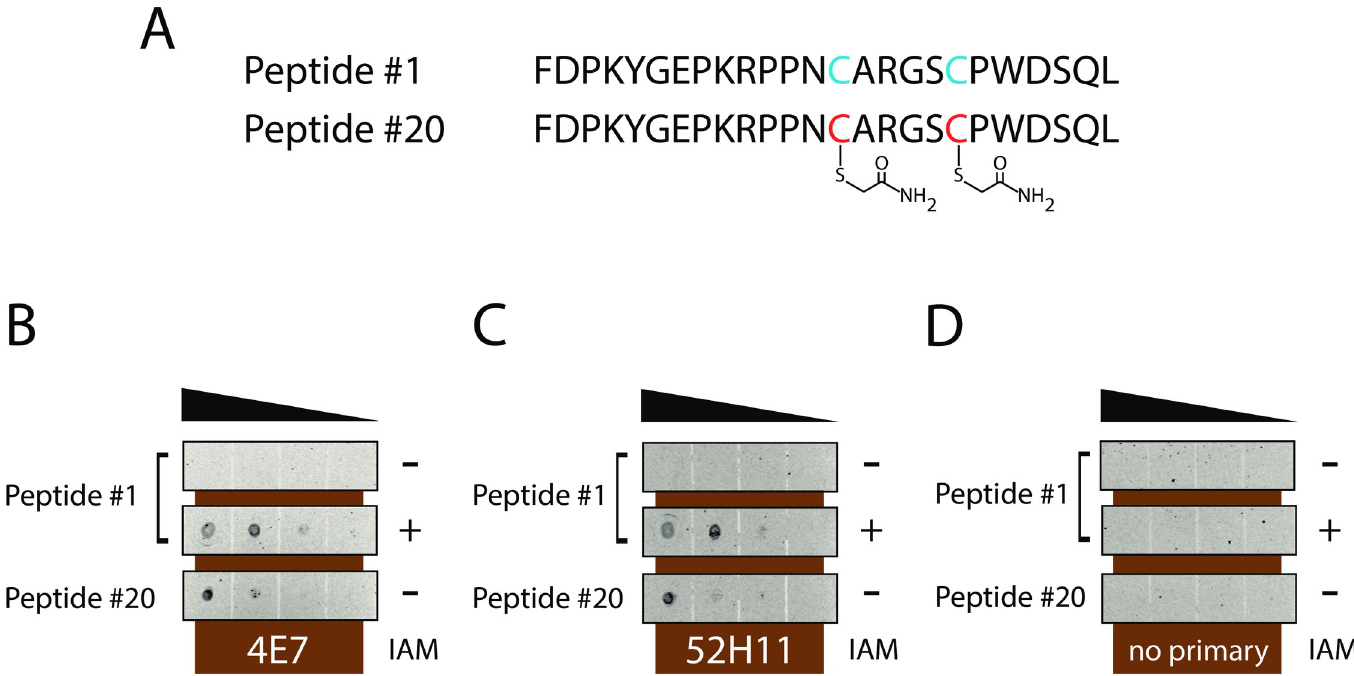
Fig 1. Two monoclonal antibodies recognize CAM-cys modified peptide sequences. (A) MYADML2 peptides used to screen for reactivity to modified cysteines lack the first anchoring cysteine present in the immunogen. Cysteine residues are highlighted in blue in peptide #1, which contains only natural amino acids. Peptide #20 was synthesized with two CAM-cys residues shown in red. An aliquot of peptide #1 was reacted with IAM (5 mM) for two hours at 37˚C prior to application to membranes in the middle row of (B-D). One microliter dots of these peptides were applied to nitrocellulose at decreasing concentrations (1,000, 100, 10, and 1.0 μ g/mL; denoted by triangles in B-D). Finally, membranes were probed with monoclonal antibodies 4E7 (B) and 52H11 (C) followed by secondary antibodies or with secondary antibodies alone (D) as a control.